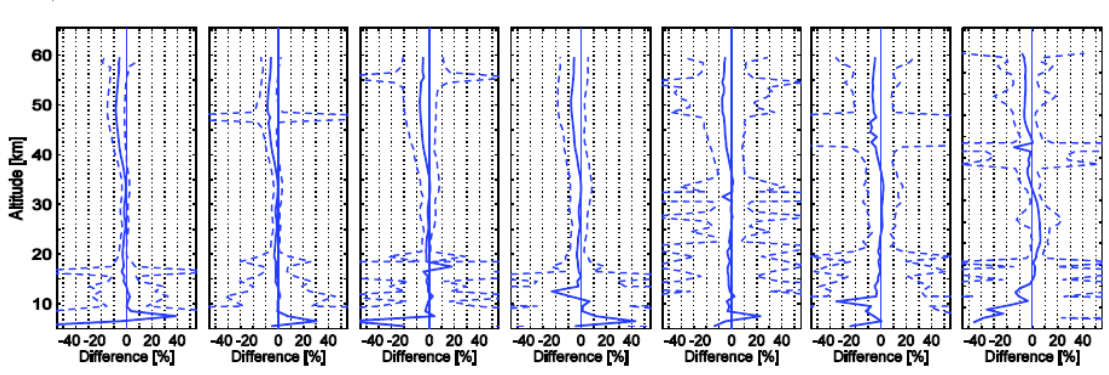
Figure 3: The mean relative differences for the direct version comparisons for O left) to 2010 (far